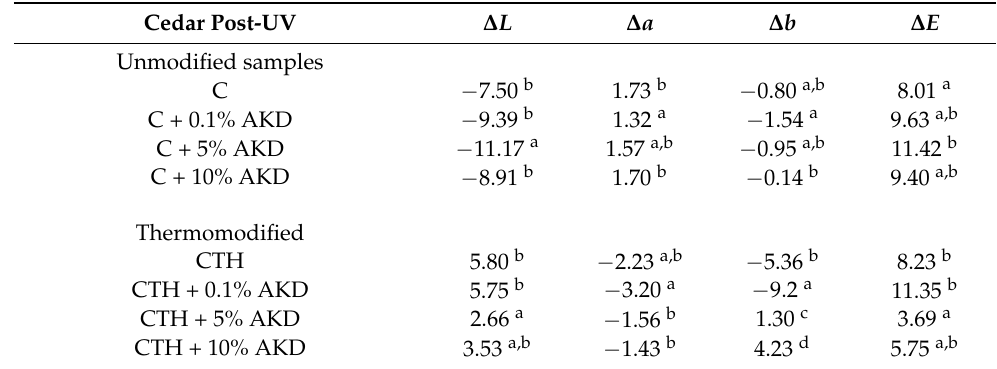
Table 3. Colour changes (mean value) for both unmodified and thermally modified cedar wood samples with AKD after UV irradiation. Means with the same letter are not significantly different from each other (p > 0.05 ANOVA followed by Duncan test)